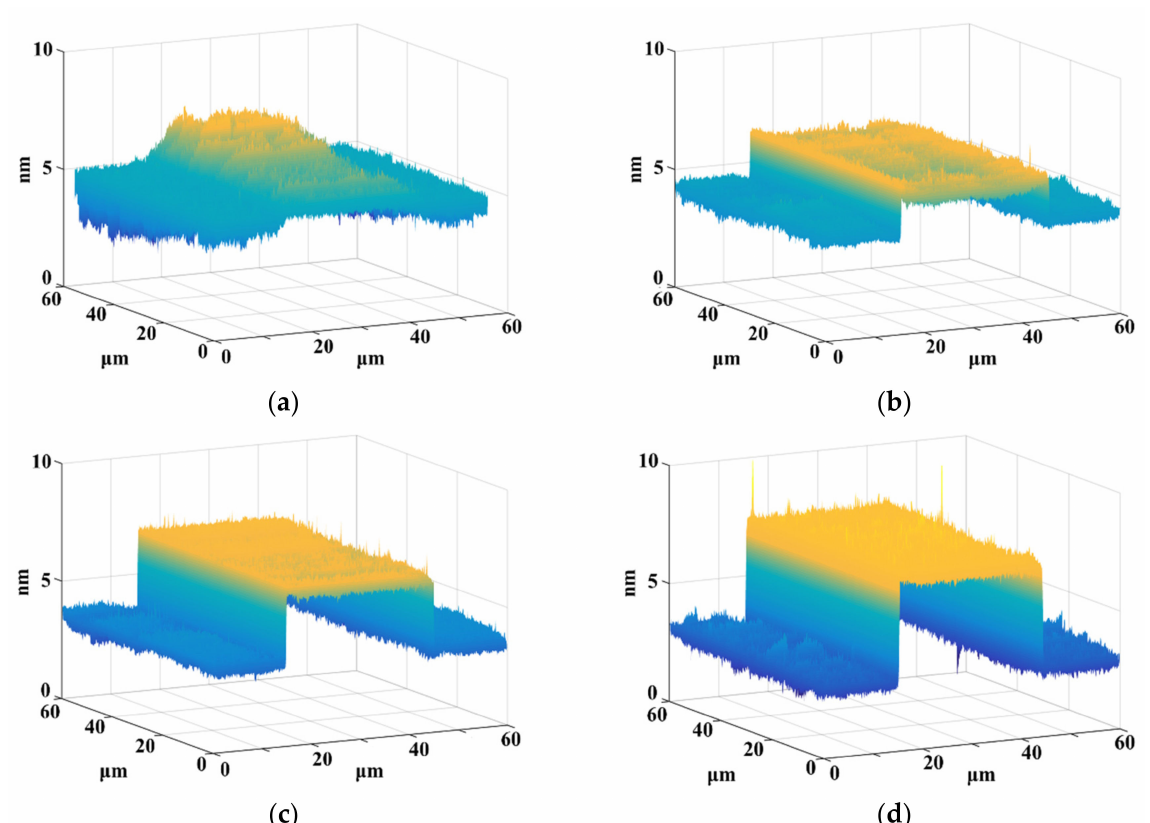
Figure 2. Scanning results of AFM for different heights of nano-steps: ( a ) 1 nm nano-step, ( b ) 2 nm nano-step, ( c ) 3 nm nano-step, ( d ) 4 nm